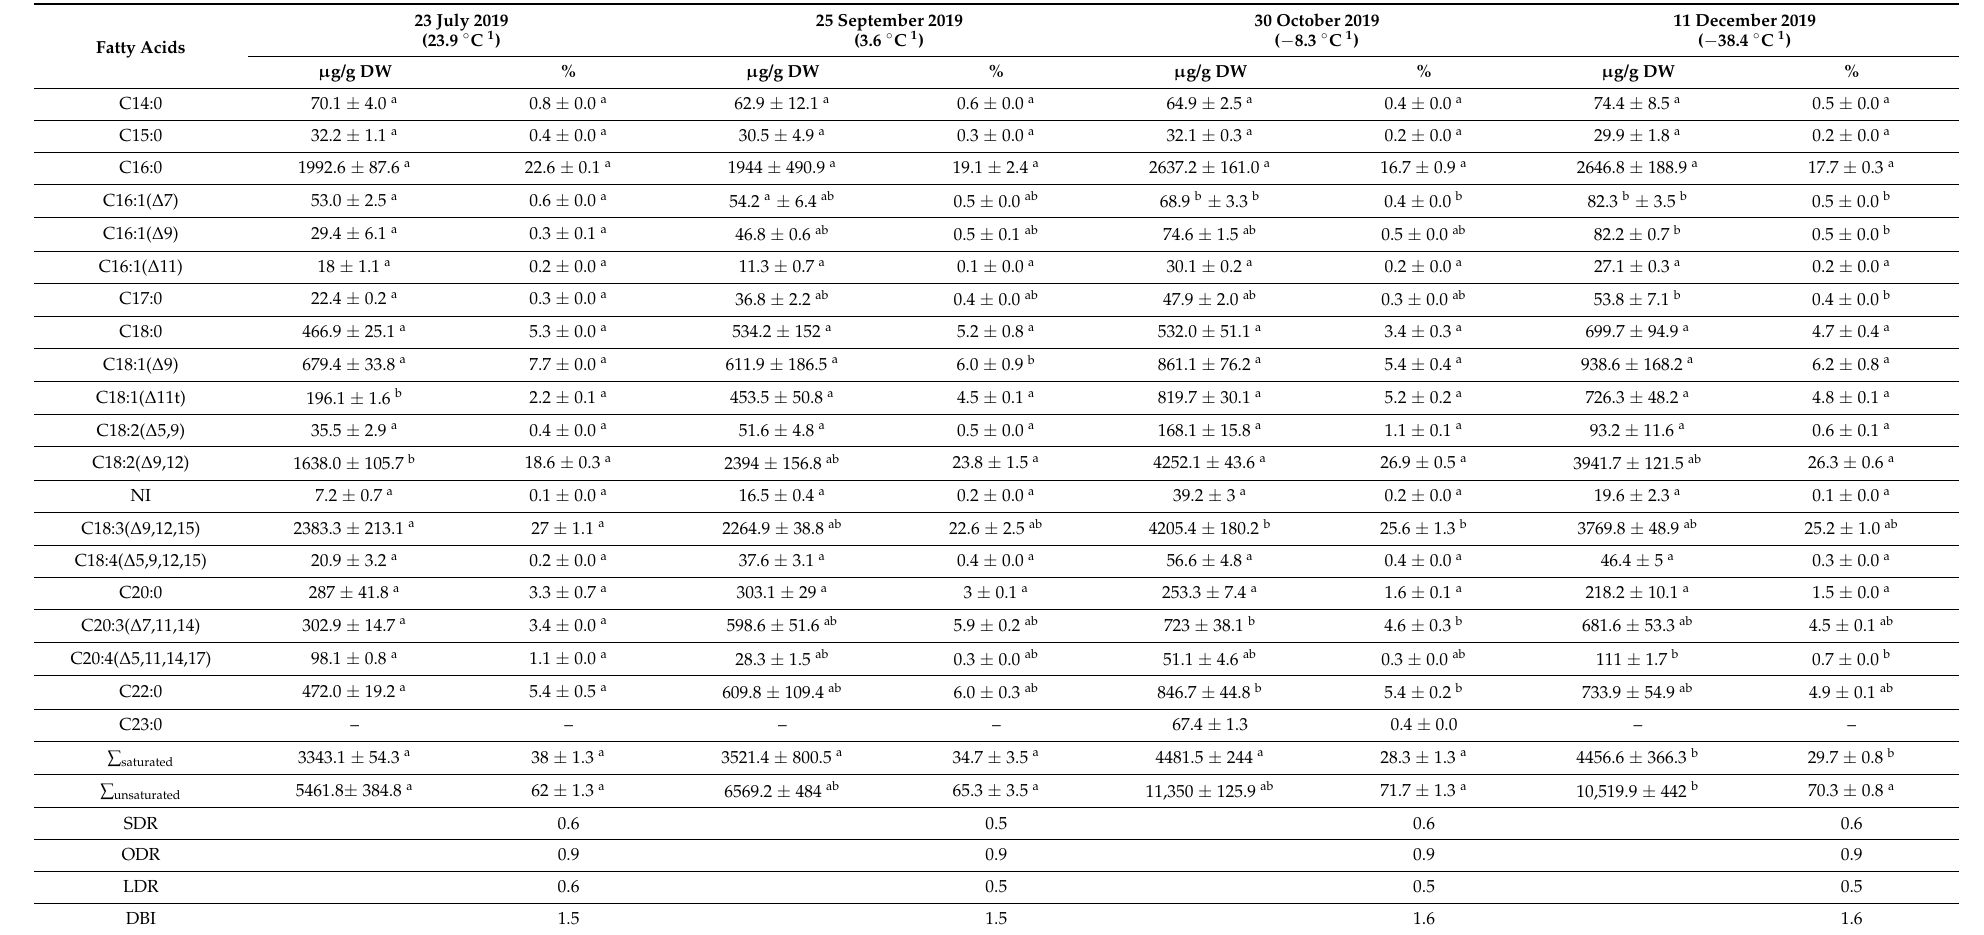
Table 2. Seasonal dynamics of fatty acyl content of lipids in shoots of E. monosperma growing in Central